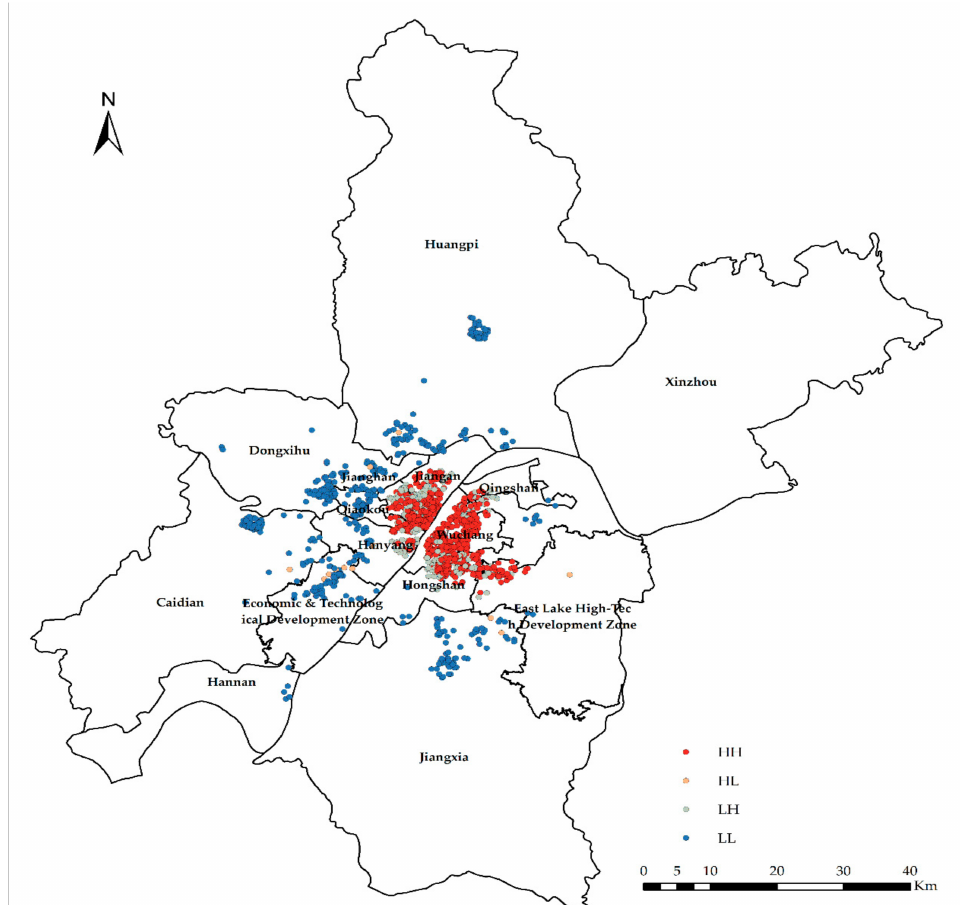
Figure 7. Clustering and outlier type of the